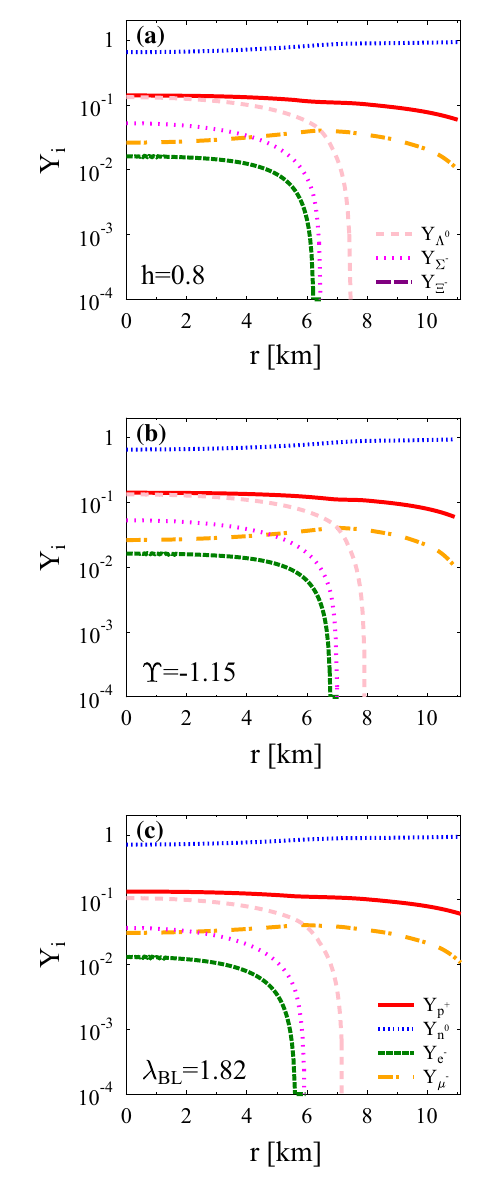
Fig. 5 Impact of anisotropic pressure on constituent composition pro- files for 2 M (cid:3) NS with hyperons. a For HB anisotropic model, b for DY anisotropic model, and c for BL anisotropic model